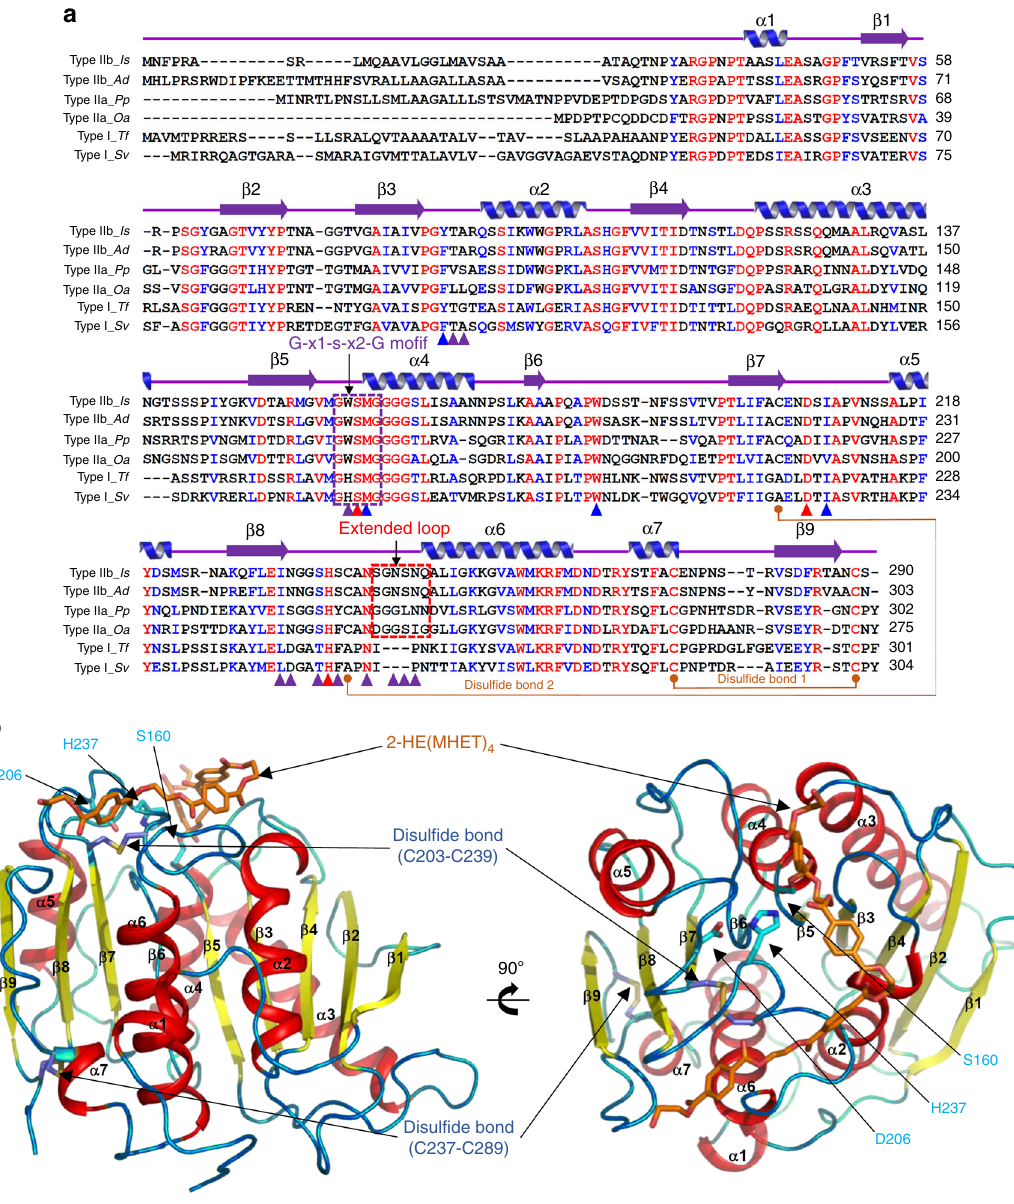
Fig. 1 Crystal structure of Is PETase. a Amino-acid sequence alignment of PET-degrading enzymes. Amino-acid sequences of six PET-degrading enzymes, two each of type I, type IIa, and type IIb, are compared. Secondary structure elements are drawn on the basis of the Is PETase structure and shown with a purple-colored arrow ( β -sheet) and blue-colored helix ( α -helix). The Gly – x1 – Ser – x2 – Gly motif and the extended loop are highlighted as purple and red color boxes, respectively. Residues involved in enzyme catalysis and constitution of subsite I and subsite II are indicated by red-, blue- and purple-colored triangles, respectively. The disul fi de bond found in all six enzymes is indicated with an orange-colored line and labeled with ‘ Disul fi de bond 1 ’ . The additional disul fi de bond found only in Is PETase is also indicated with an orange-colored line and labeled with ‘ Disul fi de bond 2 ’ . Is , Ad , Pp , Oa , Tf , and Sv are representations of PET-degrading enzymes from Ideonella sakaiensis , Acidovorax dela fi eldii , Pseudomonas pseudoalcaligenes , Oleispira antarctica , Thermobi fi da fusca , and Saccharomonospora viridis , respectively. b Structure of Is PETase. The monomeric structure is shown as a ribbon diagram. The three residues of Ser160, Asp206 and His237 forming a catalytic triad are shown as cyan-colored sticks, and the two disul fi de bonds are as light-blue-colored sticks. The simulated 2-HE(MHET) 4 molecule at the active site is shown as an orange-colored stick. The right side fi gure is rotated 90° horizontally from the left side fi